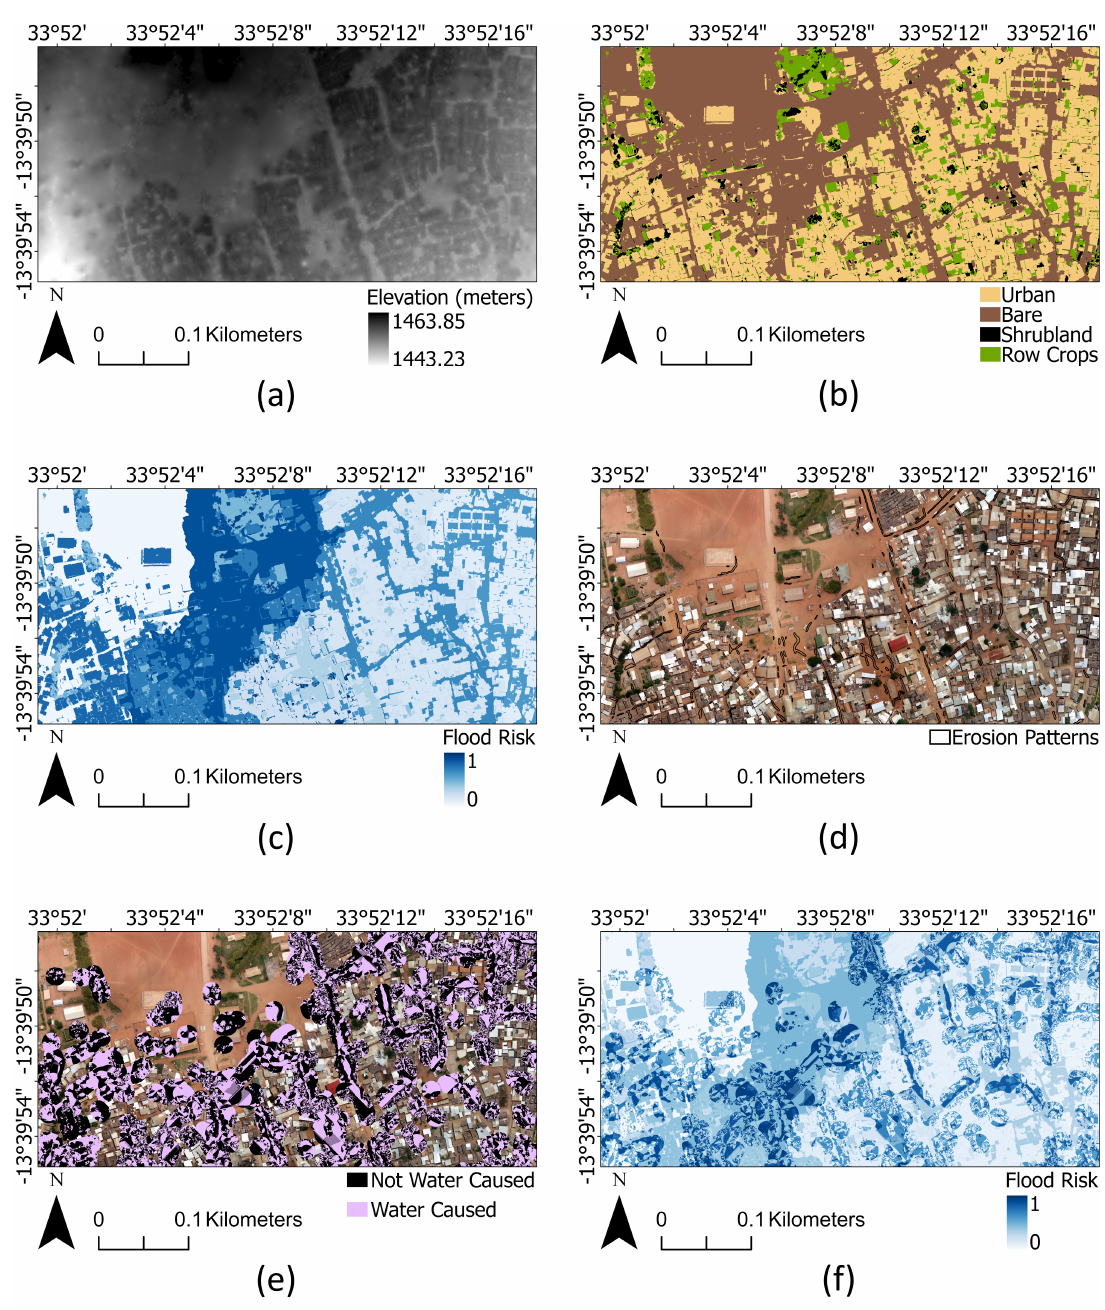
Figure 16. A small study area of Dzaleka Refugee Camp through flood analysis processing: ( a ) DTM; ( b ) land use map; ( c ) initial flood model; ( d ) erosion patterns; ( e ) erosion patterns compared to flow direction; ( f ) comprehensive flood